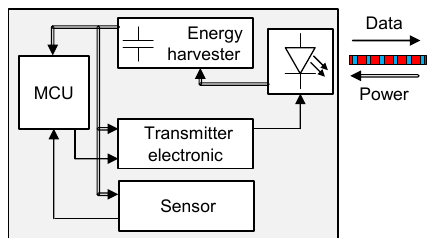
Figure 20. Block diagram of the sensor node.